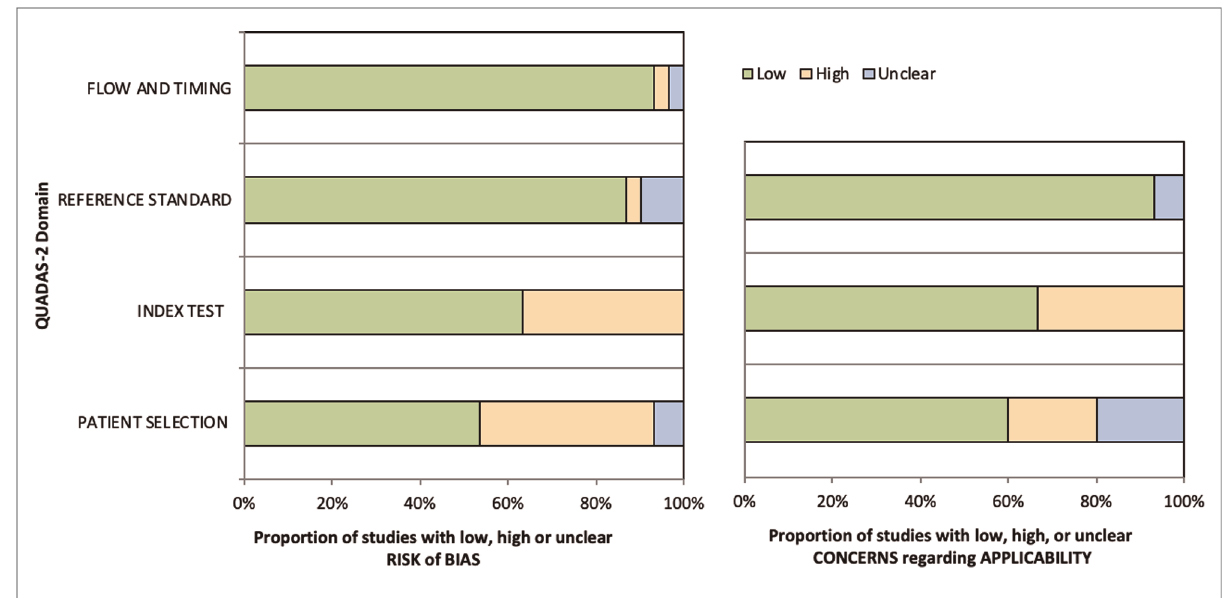
FIGURE 2 QUADAS-2 tool assessment on Risk of Bias (Left bar chart) and Applicability (Right bar